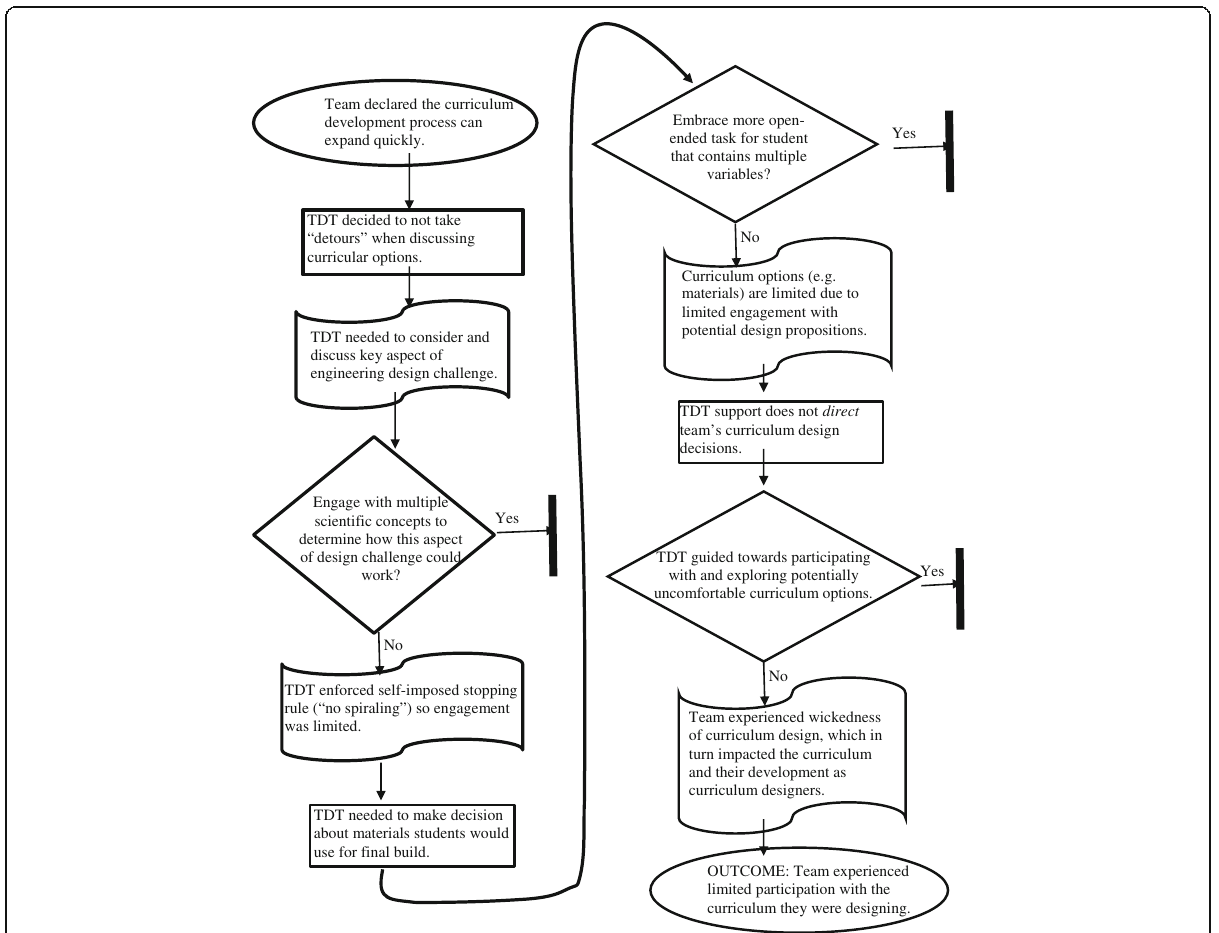
Fig. 3 Map of team Engineering to the Rescue ’ s approach to curriculum unit